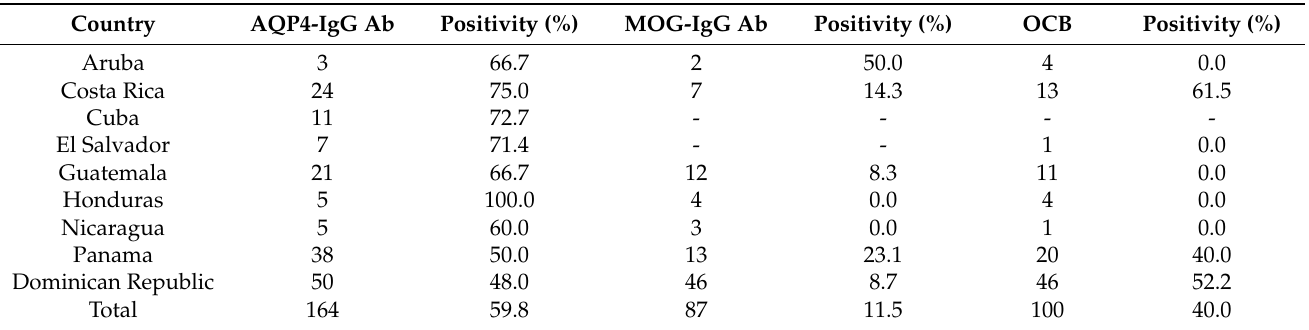
Table 4. Profile of serum antibodies and oligoclonal bands (CSF) in 186 patients with NMOSD in Central America and the